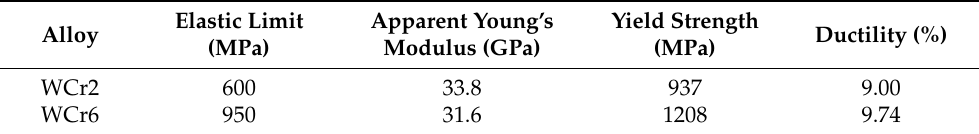
Figure 11. Results from the compression tests. Dotted lines: engineering strain/stress curves; full lines: true stress/strain curves, showing a ductility of 9.00% and 9.74%. Table 4. Results of compression tests. Ductility is the plastic deformation only at the maximum